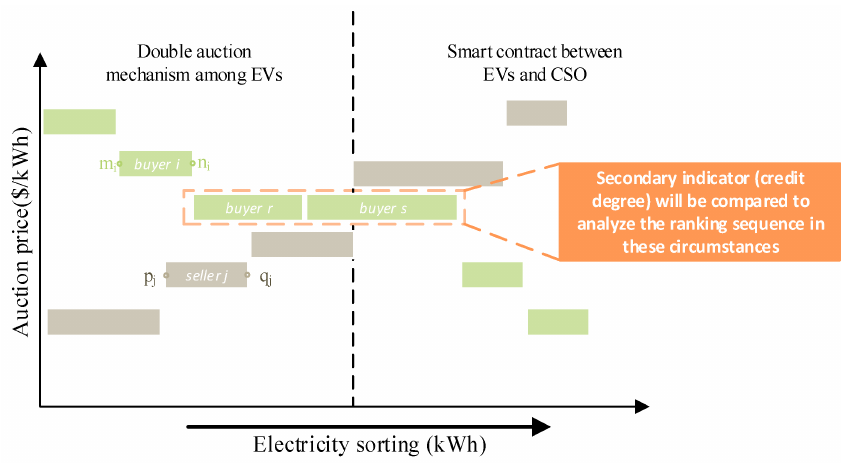
Figure 2. Double auction